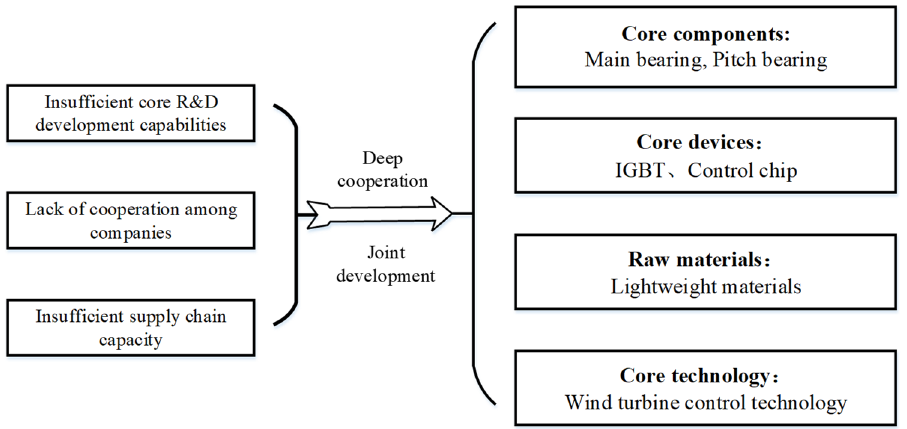
Figure 6. Technology development trends of offshore wind turbines.